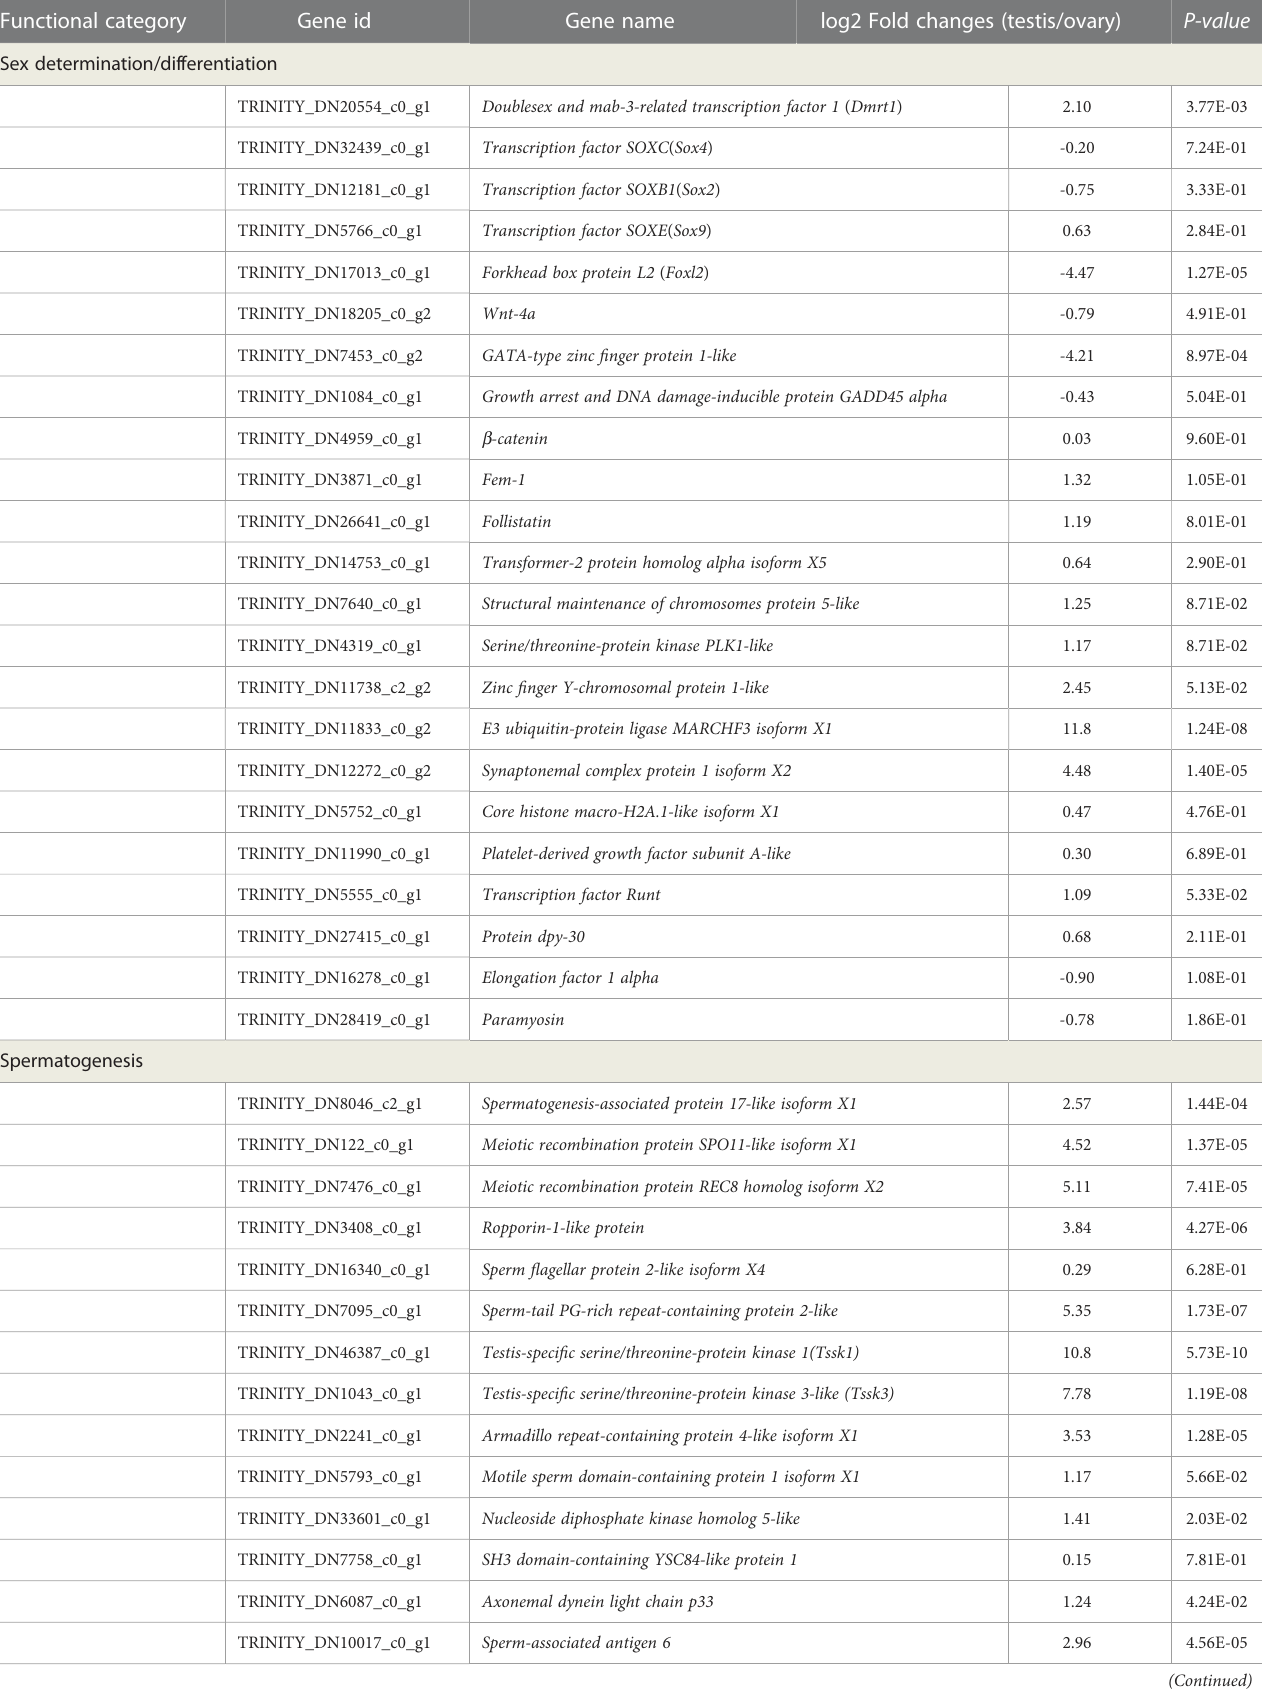
TABLE 3 Summary of differential and non-differentially expressed genes related to sex determination/differentiation and gonadal development in the transcriptome of C. sinensis . Functional